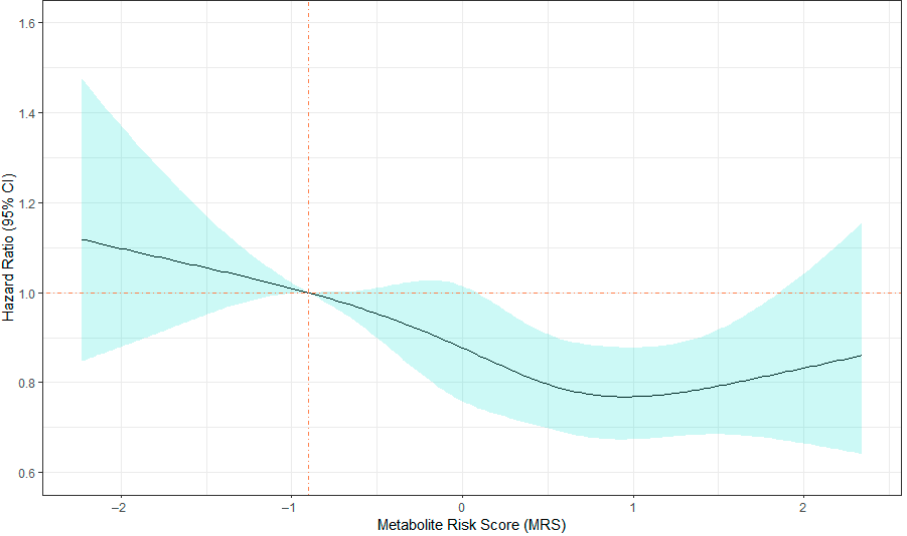
Figure 2. Association between standardized MRS and log hazard ratio for all-cause mortality in 3802 participants from the Atherosclerosis Risk in Communities study.